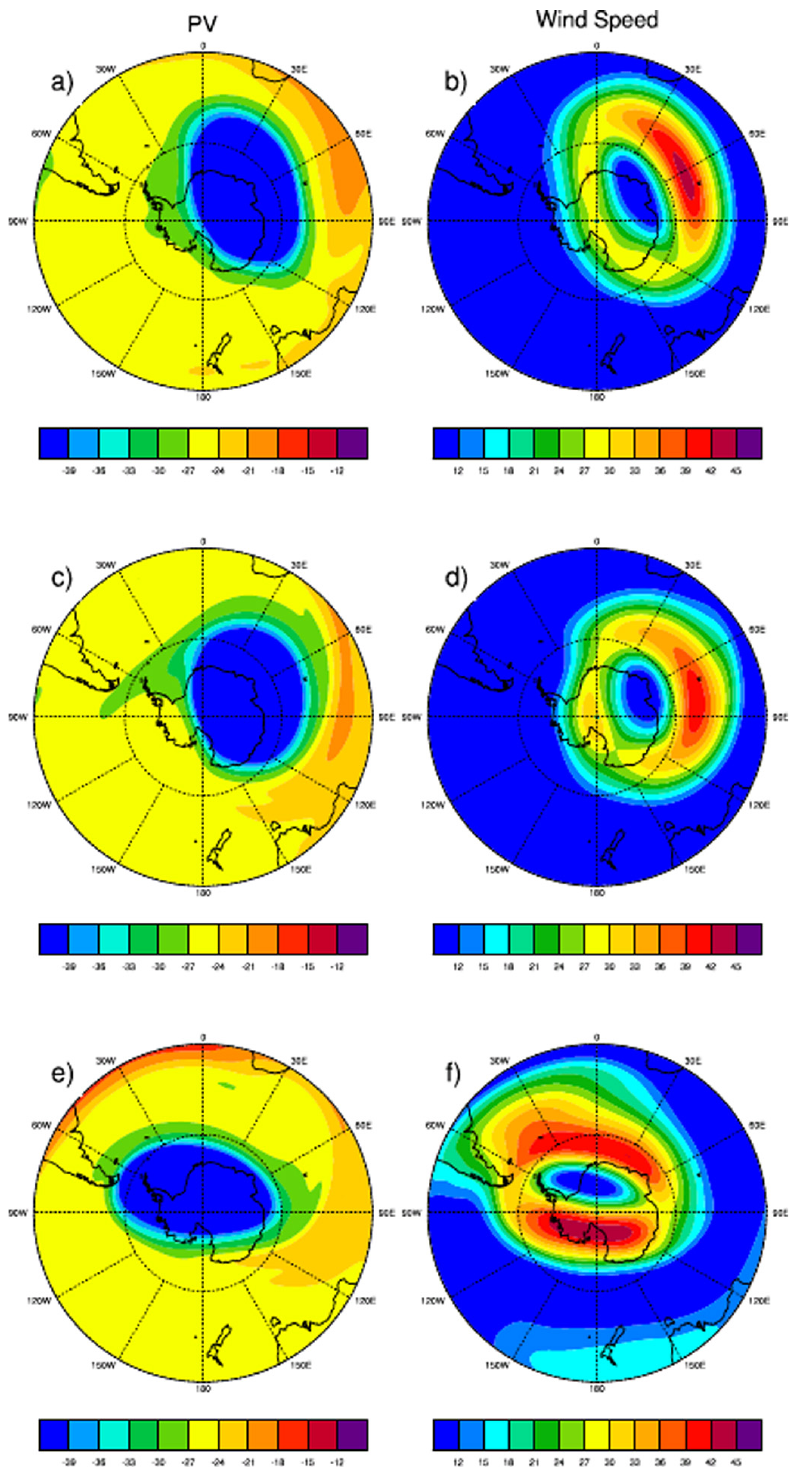
Fig. 8. Distributions of PV (a) and the mean wind speed (b) at 500K used to initialize two idealized simulations. These fields are obtained from the NCEP-FNL analyses after averaging the instantaneous fields between 19 and 25 November 2005. (c) and (d) show the PV and the wind fields simulated after 5 days. (e) and (f) are the same as (c) and (d) except that the forcing associated with the QSW1 is removed from the boundary conditions used (the pressure at the top (700K), and the geopotential at the bottom